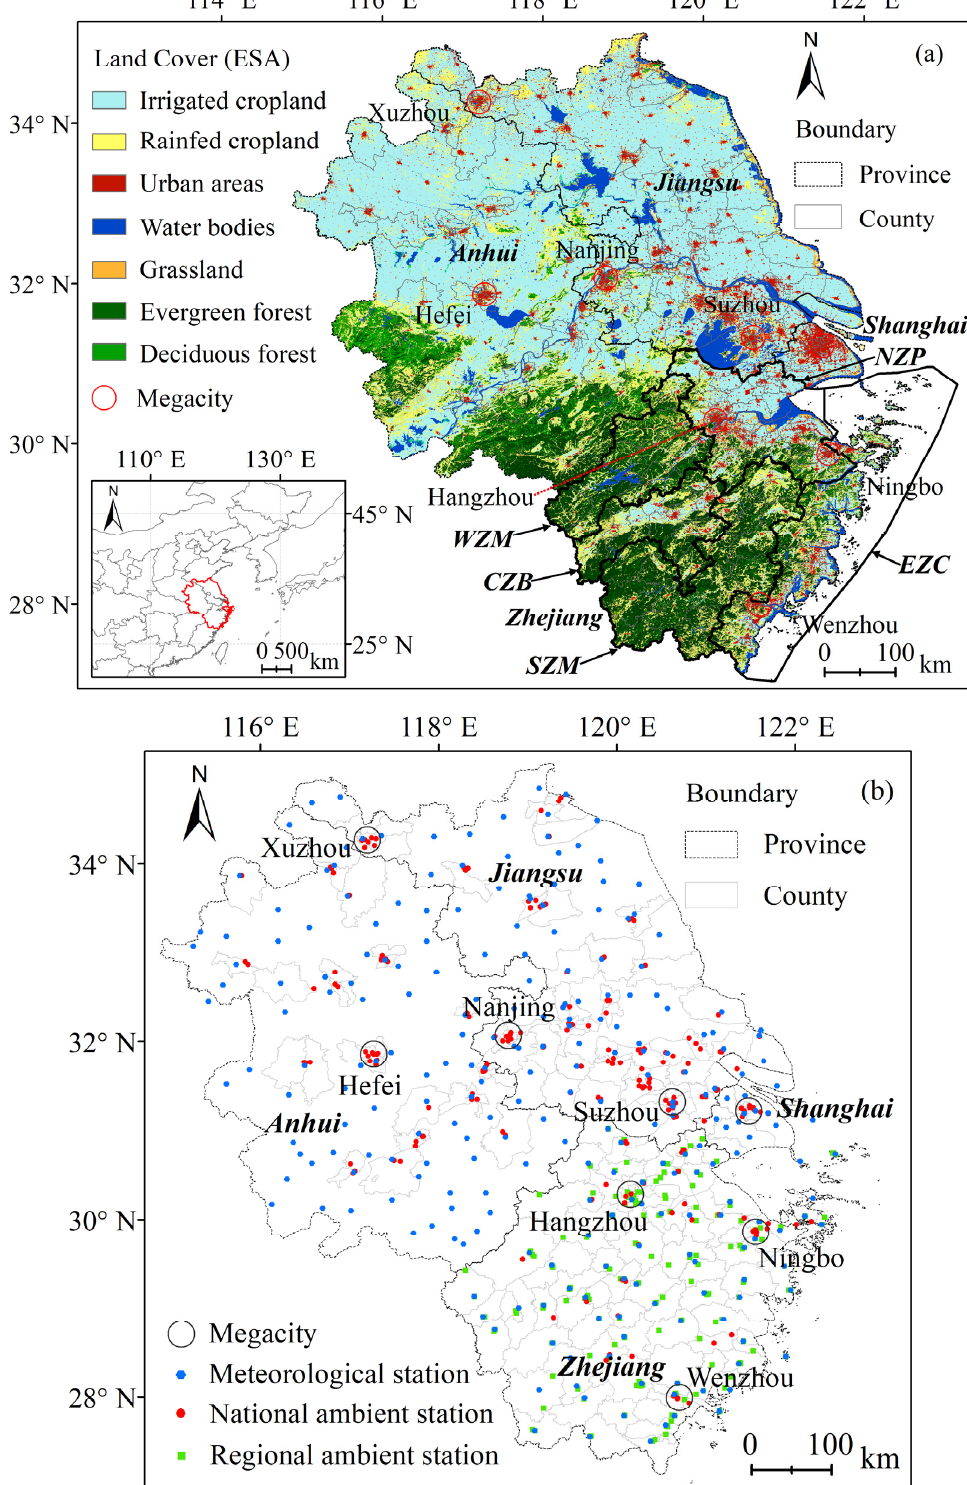
Figure 1. ( a ) Geographical map and land cover, ( b ) dense network of ambient and meteorological stations over the Yangtze River Delta used in this study. Megacities with residents more than 9.0 million in 2021 are shown with a red/black circle. Selected regions of different land cover are highlighted with black lines ( a ). Regional ambient stations for O 3 measurements are mainly distributed in Zhejiang province ( b